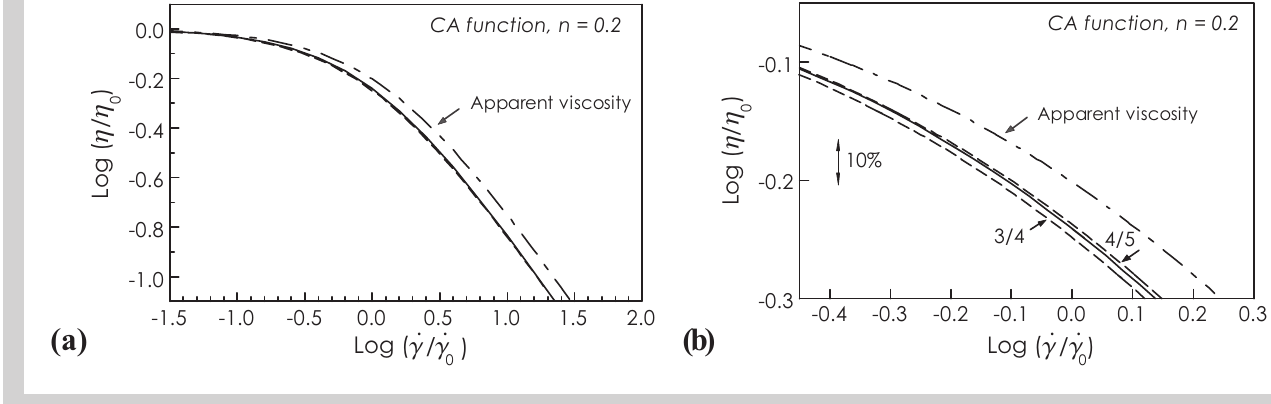
Figure 4: The dashed line in panel a) shows the behavior of the Cross-Kaye (3/4 ths ) correc- tion of the apparent viscosi- ty relative to the actual vis- cosity (solid line) generated using the Carreau-type function (Eq. 16) with n = 0.2. The blow-up in panel b) adds the result using the 4/5 ths